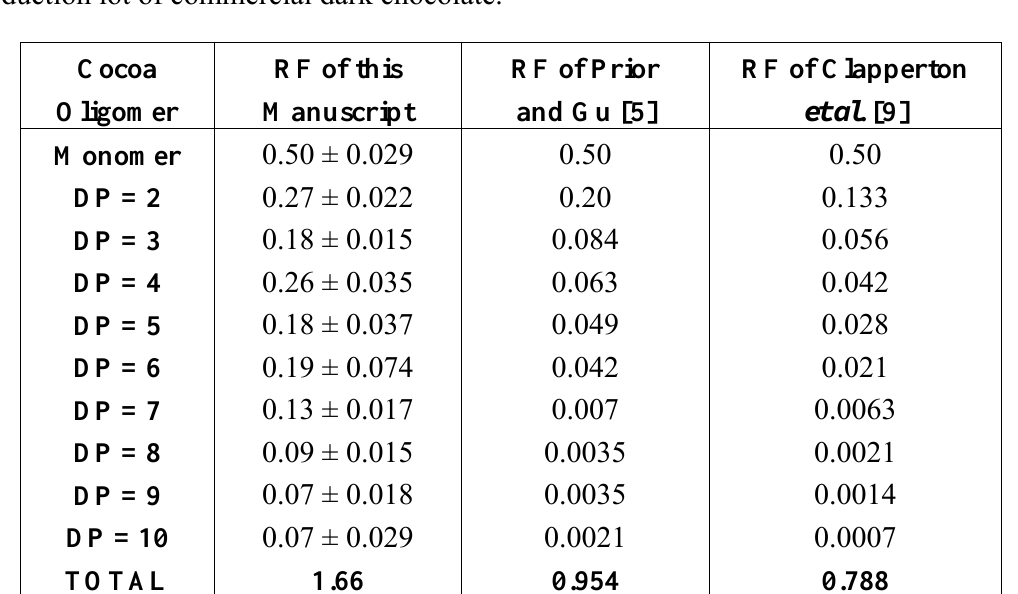
Table 4. Calculation of the procyanidin content of a commercial US dark chocolate in mg/g of product using the response factors (RF) shown in Table 4. Average ± standard deviation reported for RF of this report are for 14 independent determinations of the same production lot of commercial dark